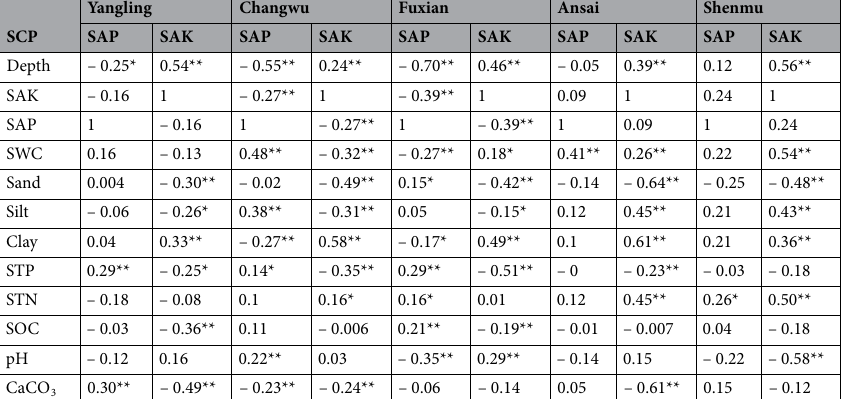
Table 2. Pearson’s correlation coefficients between the soil available phosphorus (SAP), soil available potassium (SAK), and selected soil properties. SCP soil chemical properties, SWC soil water content, STN soil total nitrogen, STP soil total phosphorus, SOC soil organic carbon, SAP soil available phosphorus, SAK soil available potassium. *Correlation is significant at the 0.05 level. **Correlation is significant at the 0.01 level.